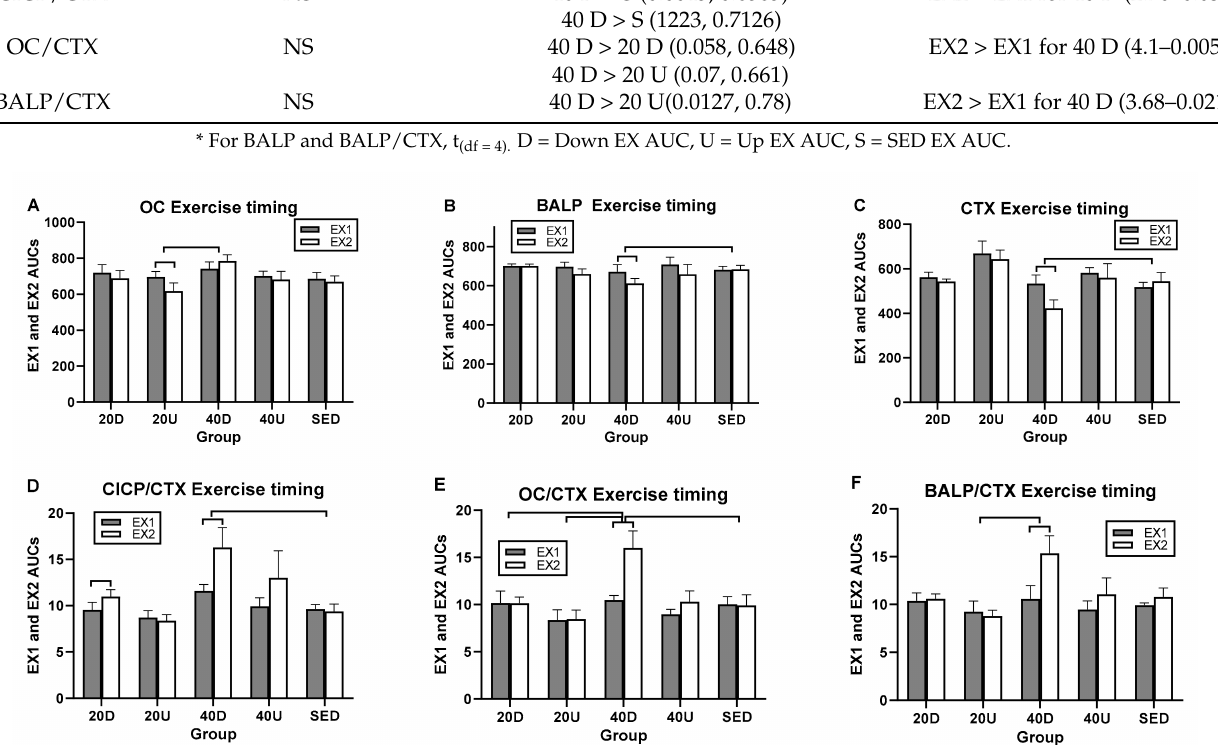
Figure 5. Between- and within-group comparisons for timing effects of EX1 and EX2 AUCs on markers of bone formation and their ratios. Between-group differences in EX AUCs were seen between 40Down trial and SED in BALP ( B ), CTX ( C ), CICP/CTX ( D ), and OC/CTX ( E ) trials; between 40 Down and 20 Up trials in OC ( A ), OC/CTX ( E ), and BALP/CTX ( F ); and 20 Down in OC/CTX ( E ). Within groups, EX1 CTX AUCs were higher than EX2 AUCs for OC ( A ), BALP ( B ), and CTX ( C ). EX2 AUCs were higher than EX1 AUCs for the three bone marker ratios ( D – F ). D = Down exercise AUC, U = Up exercise AUC, S = sedentary trial exercise